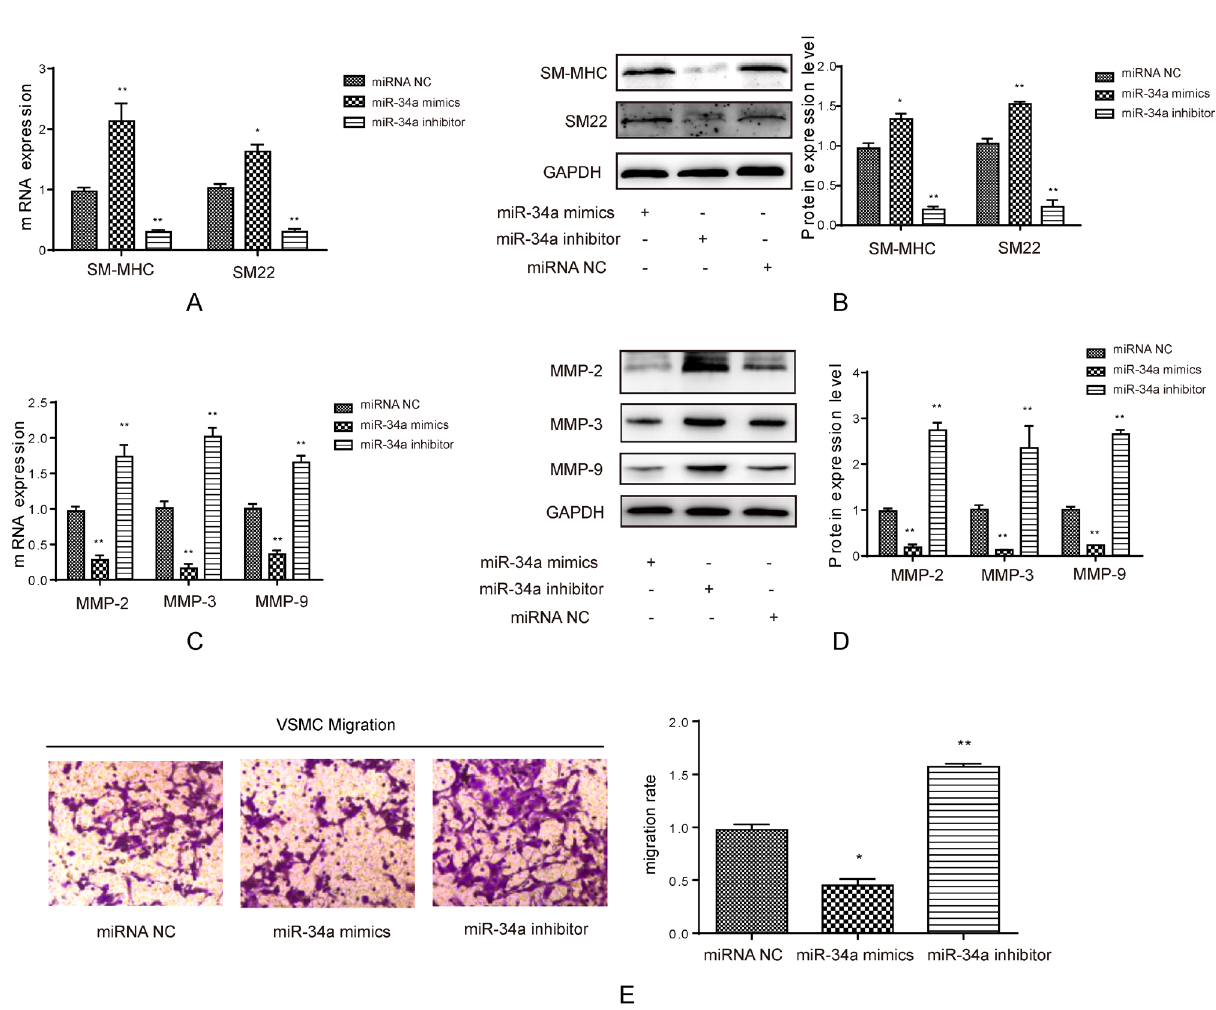
Figure 2 – The effect of miR-34a on contractile proteins. (A) Real-time PCR was used to test SM-MHC and SM22 mRNA level when transfected with miR-34a mimics and inhibitor in smooth muscle cells, *p < 0.05, **p < 0.01, compared to miRNA NC group. (B) Western blot was used to test SM- MHC and SM22 protein level when transfected with miR-34a mimics and inhibitor in smooth muscle cells, quantification was calculated based on light density of bands in Quantity One, **p < 0.01 compared to miRNA NC group. (C) Real-time PCR was used to test MMP-2, MMP-3 and MMP-9 mRNA level when transfected with miR-34a mimics and inhibitor in smooth muscle cells, **p < 0.01 compared to miRNA NC group. (D) Western blot was used to test SM-MHC and SM22 protein level when transfected with miR-34a mimics and inhibitor in smooth muscle cells, quantification was calculated based on light density of bands in Quantity One, **p < 0.01 compared to miRNA NC group. (E) Transwell assay was used to detect migration ability of smooth muscle cells when treated with miR-34a mimcs/inhibitor, quantification was calculated based on OD value in each group and normalized to miRNA NC group, *p < 0.05, **p < 0.01 compared to miRNA NC